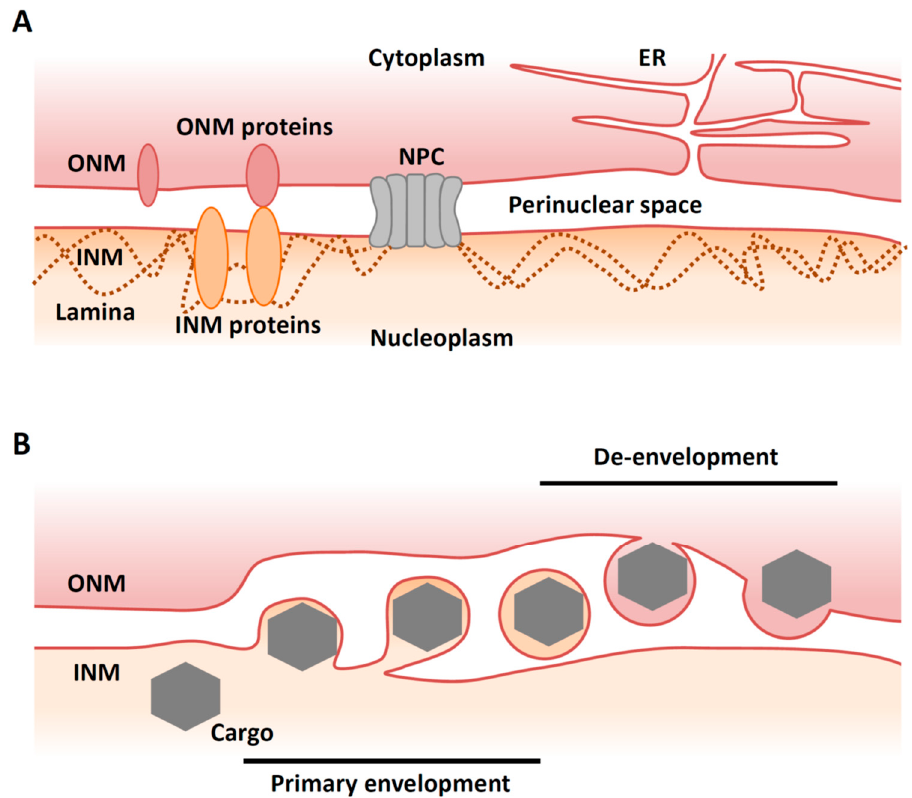
Figure 1. Overview of nuclear egress. ( A ) Illustration of a ‘normal’ nuclear envelope. INM, inner nuclear membrane; ONM, outer nuclear membrane; NPC, nuclear pore complex; ER, endoplasmic reticulum. ( B ) Illustration of vesicle-mediated nucleocytoplasmic transport. A cargo (e.g., viral capsid) in the nucleus buds through the INM to form a vesicle in the perinuclear space that then fuses with the ONM to release the complex into the cytoplasm (de-envelopment).